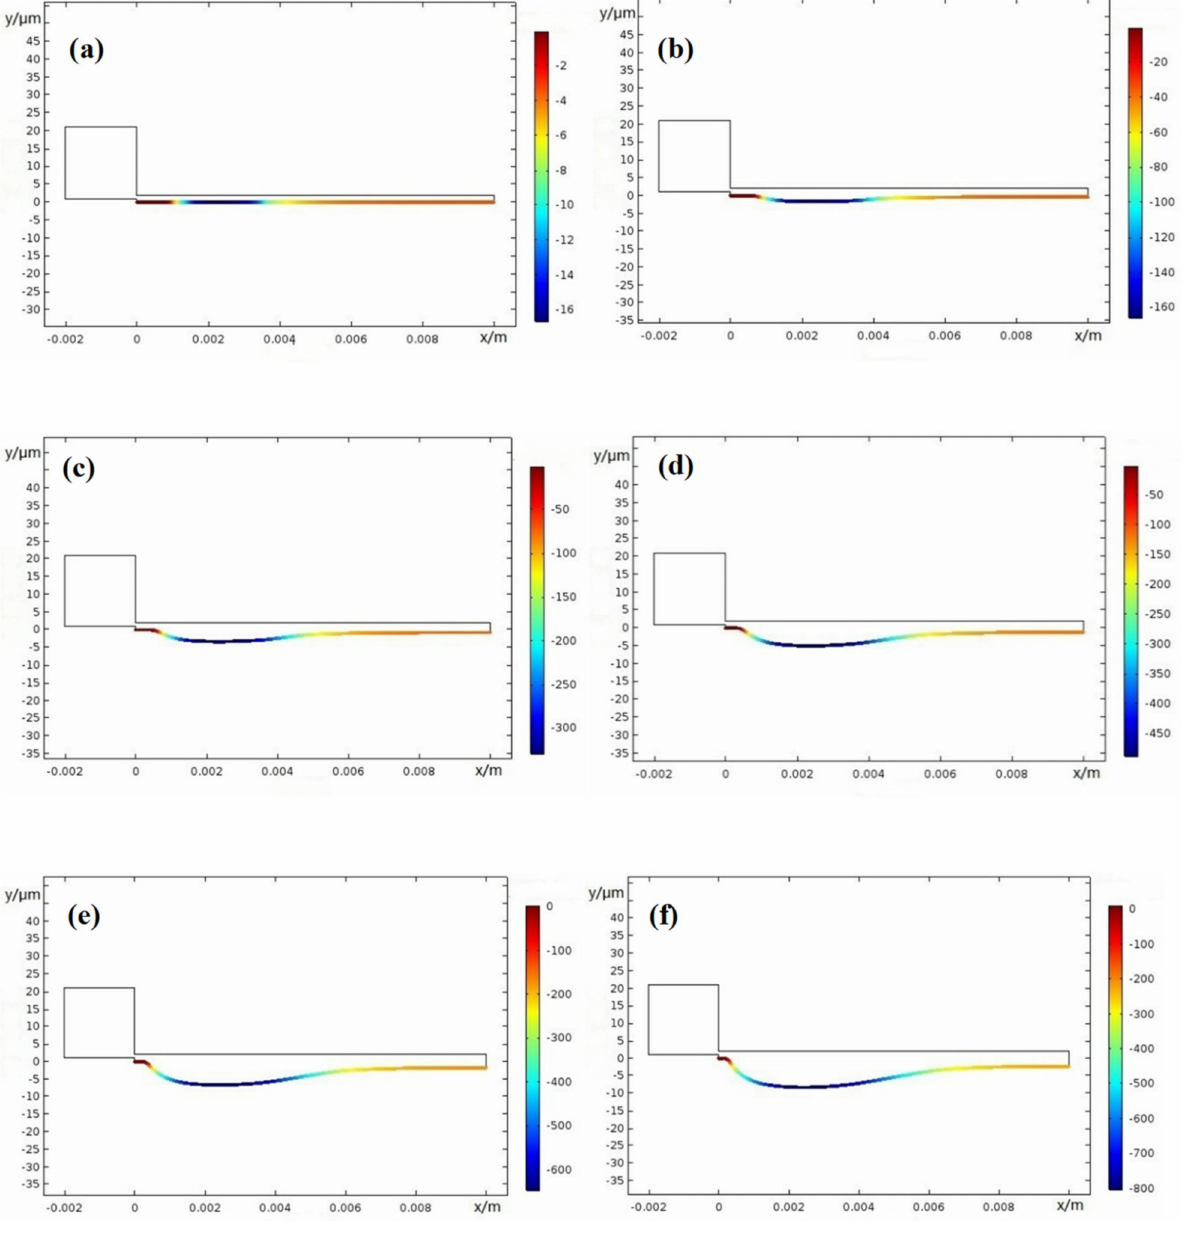
Figure 17. Damage evolution of X100 crevice corrosion at width W = 0.20 mm: ( a ) 0 weeks; ( b ) 10 weeks; ( c ) 20 weeks; ( d ) 30 weeks; ( e ) 40 weeks; ( f ) 50